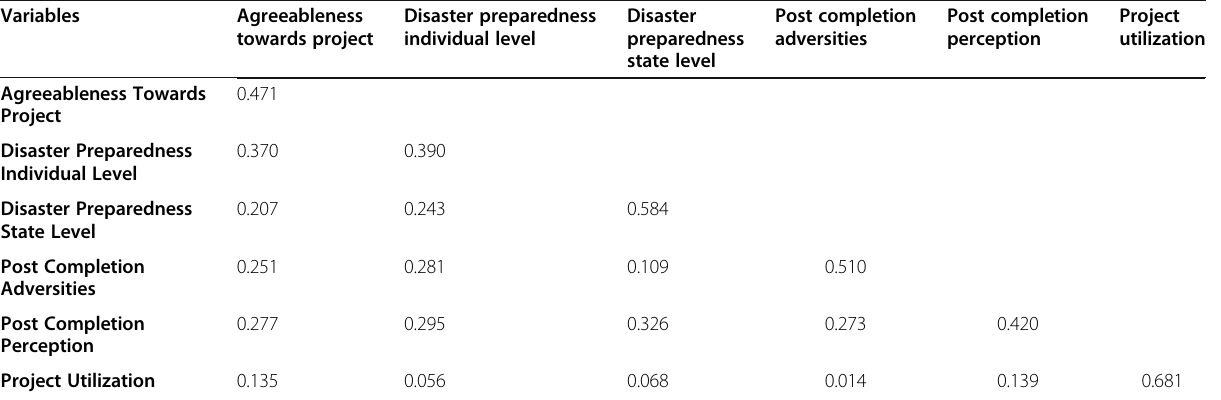
Table 5 Instrument ’ s discriminant validity (Fornell Larcker)